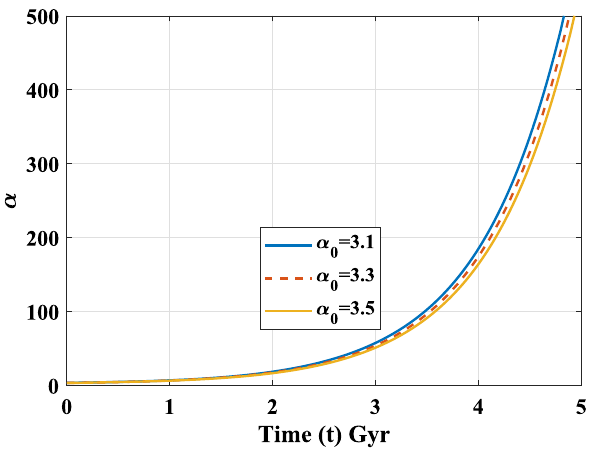
Fig. 1 Plot of skewness parameter ( α ) versus time ( t ) for k = 1 . 9, α = 1 . 2, α = 0 . 52, w = 1000, φ 1 2